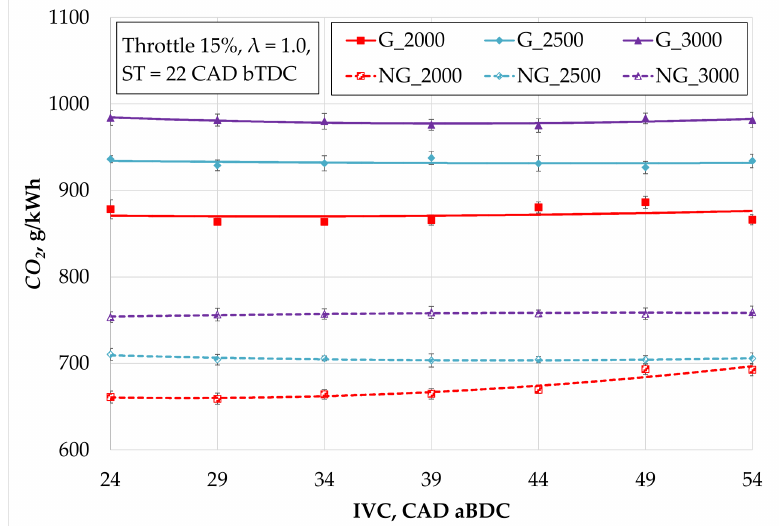
Figure 14. Change of the specific carbon dioxide emissions from an engine running on gasoline and natural gas and while changing the intake valve close timing.